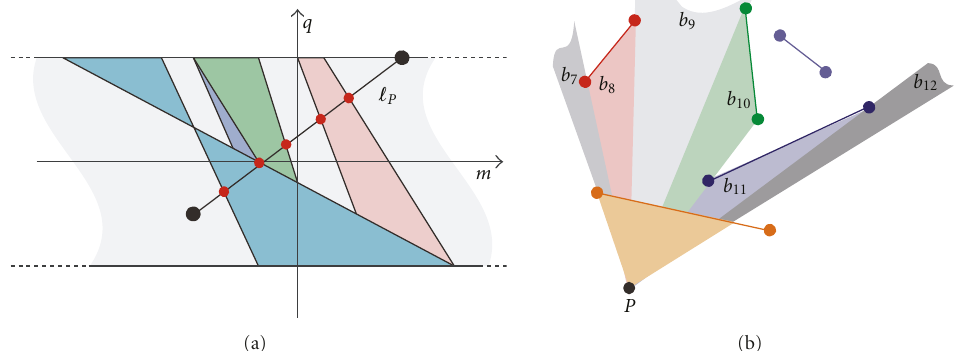
Figure 4: (a) Beam subdivision performed in the ( m , q ) domain for the bundle of rays corresponding to the reflection of the beam b 3 of Figure 3. (b) Corresponding subbeams in the geometric domain.